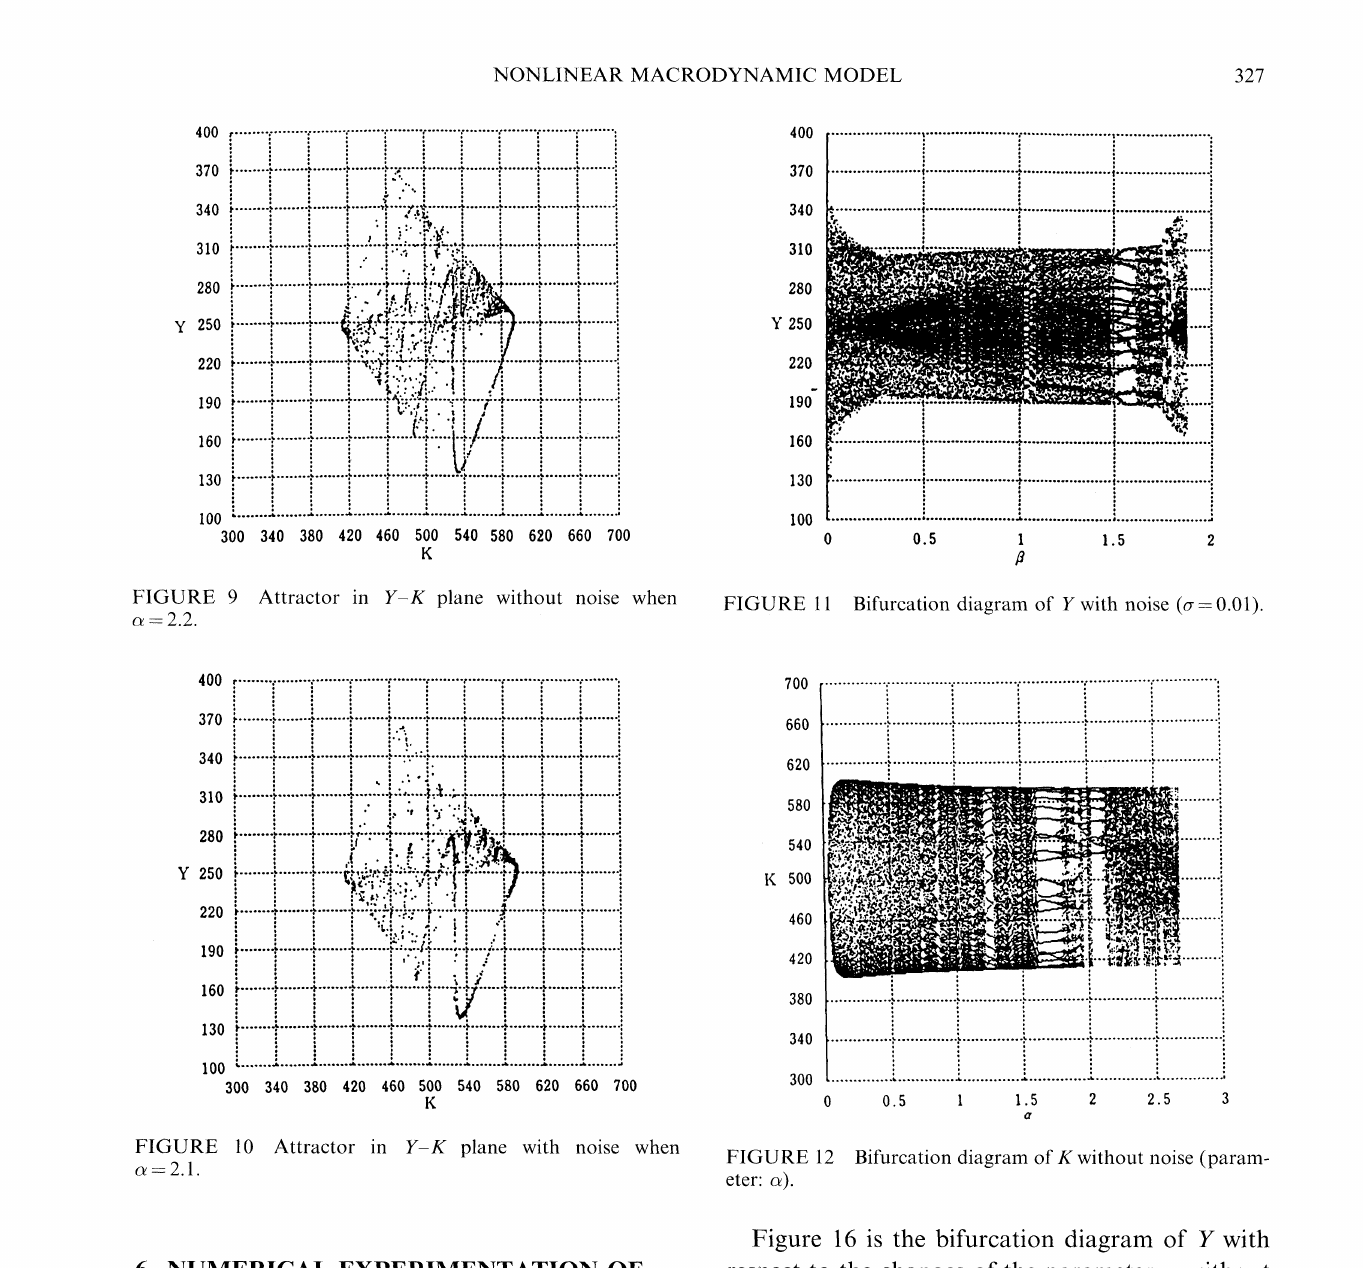
FIGURE Bifurcation diagram of Y with noise (or 0.01).